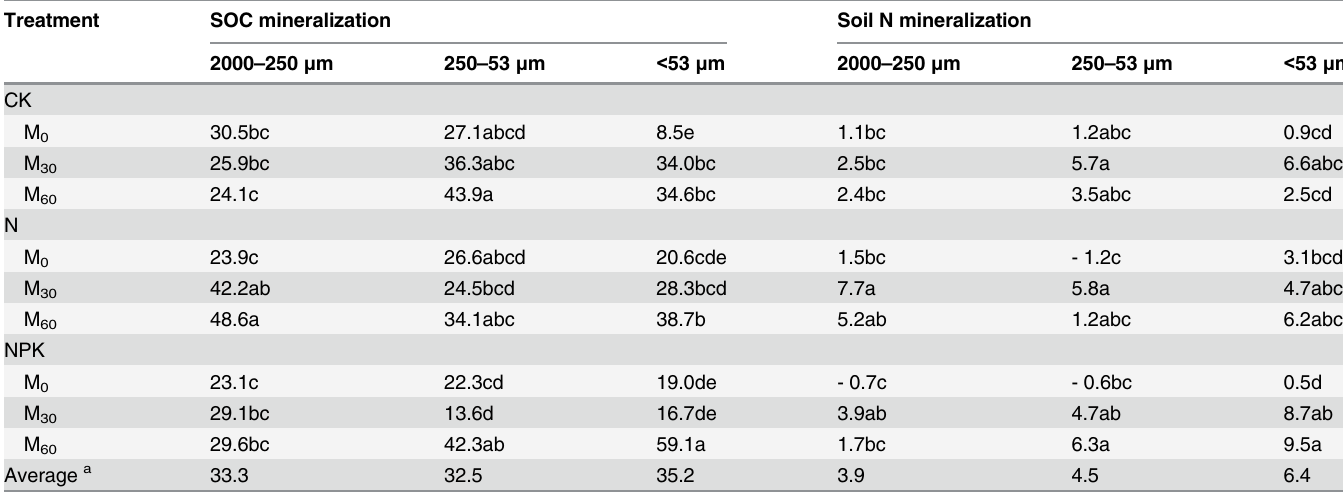
Table 2. The potential pool of soil organic carbon (SOC) and nitrogen (N) mineralized in different particle-size fractions from the control (CK) or soil that received 32 years of chemical fertilizer application (N, P: phosphorus, K: potassium) and either 0 (M 0 ), 30(M 30 ) or 60 (M 60 ) t manure ha -1 yr - 1 (mg kg -1 soil).